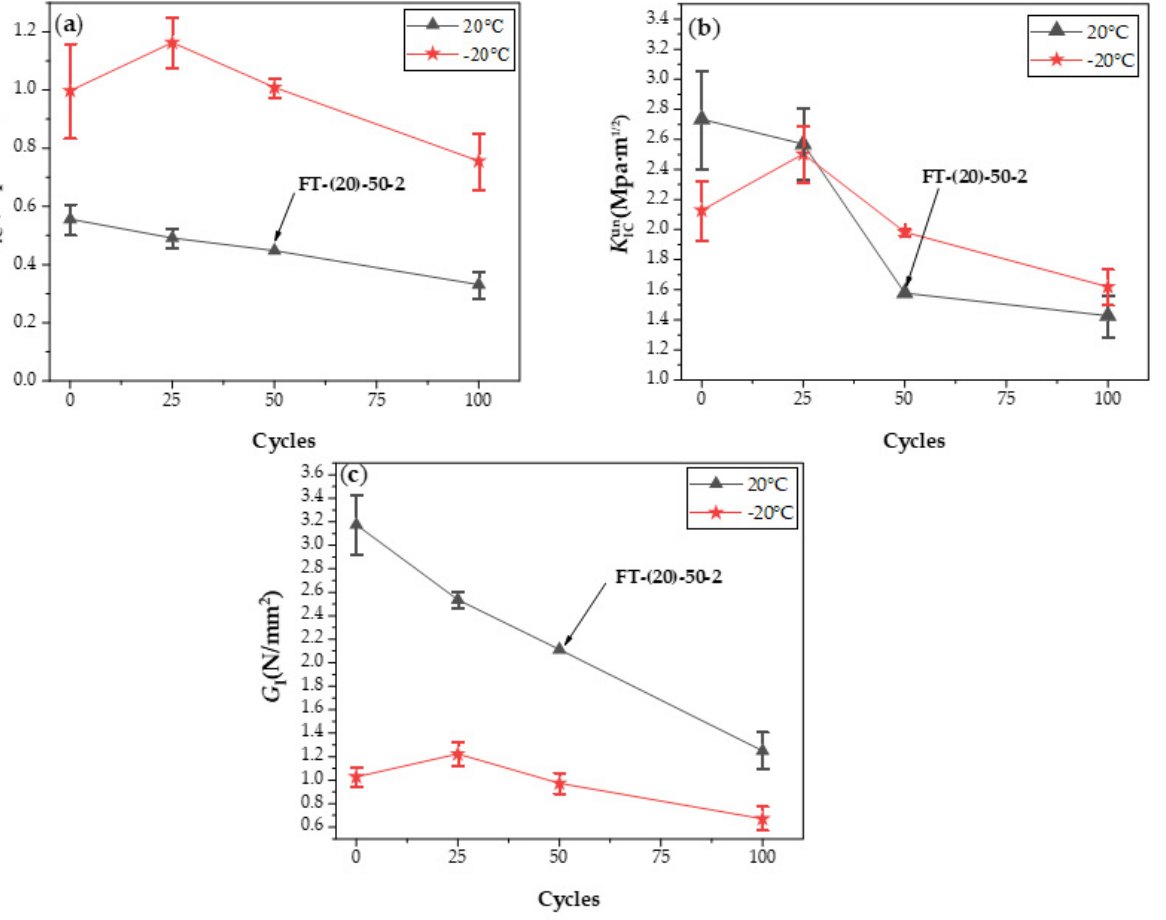
Figure 16. ( a ) K ini , ( b ) K un , and ( c ) G I changes after different freeze–thaw cycles at 20 and − 20 ◦ Figure 16. ( a ) K ICini , ( b ) K ICun , and ( c ) G changes after different freeze–thaw cycles at 20 and − 20 °C. IC IC I